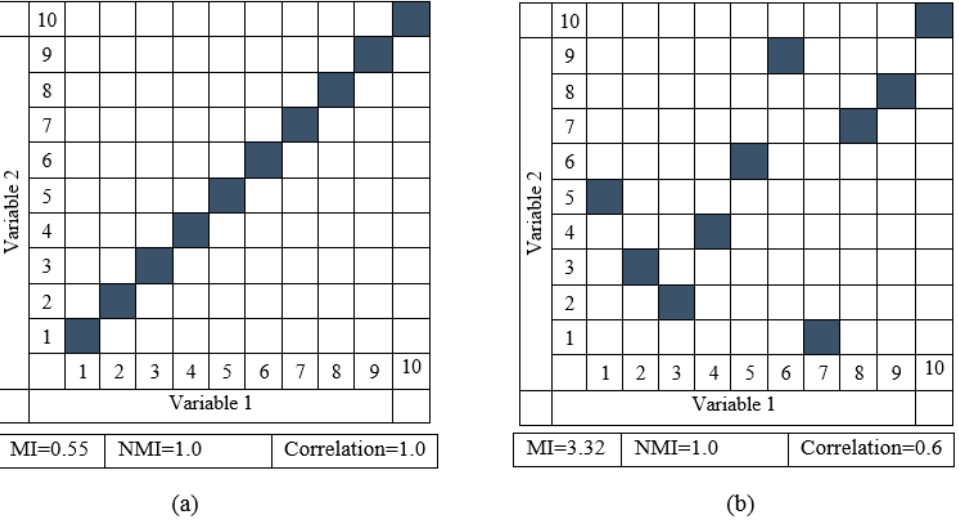
which reemphasizes the superiority of the NMI-based similarity measure.